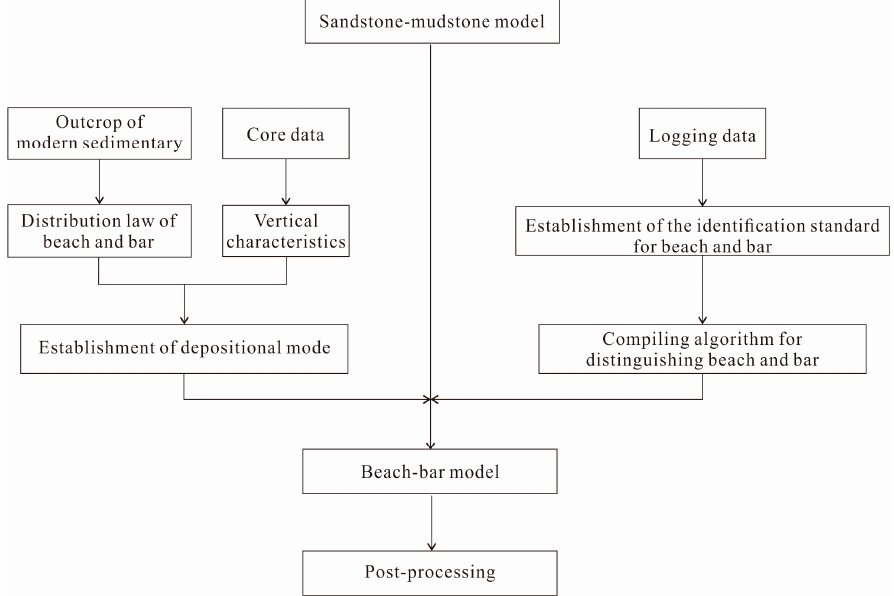
Figure 7. Flow chart of modeling based on depositional mode and sandbody volume.